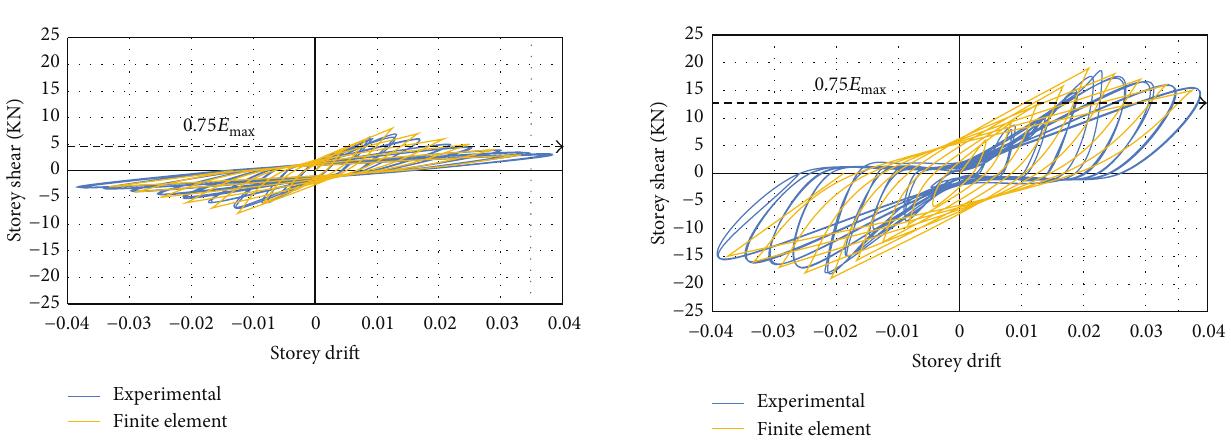
Figure 11: An experimental and finite element hysteresis response comparison for the DCL-SINGLE specimen.